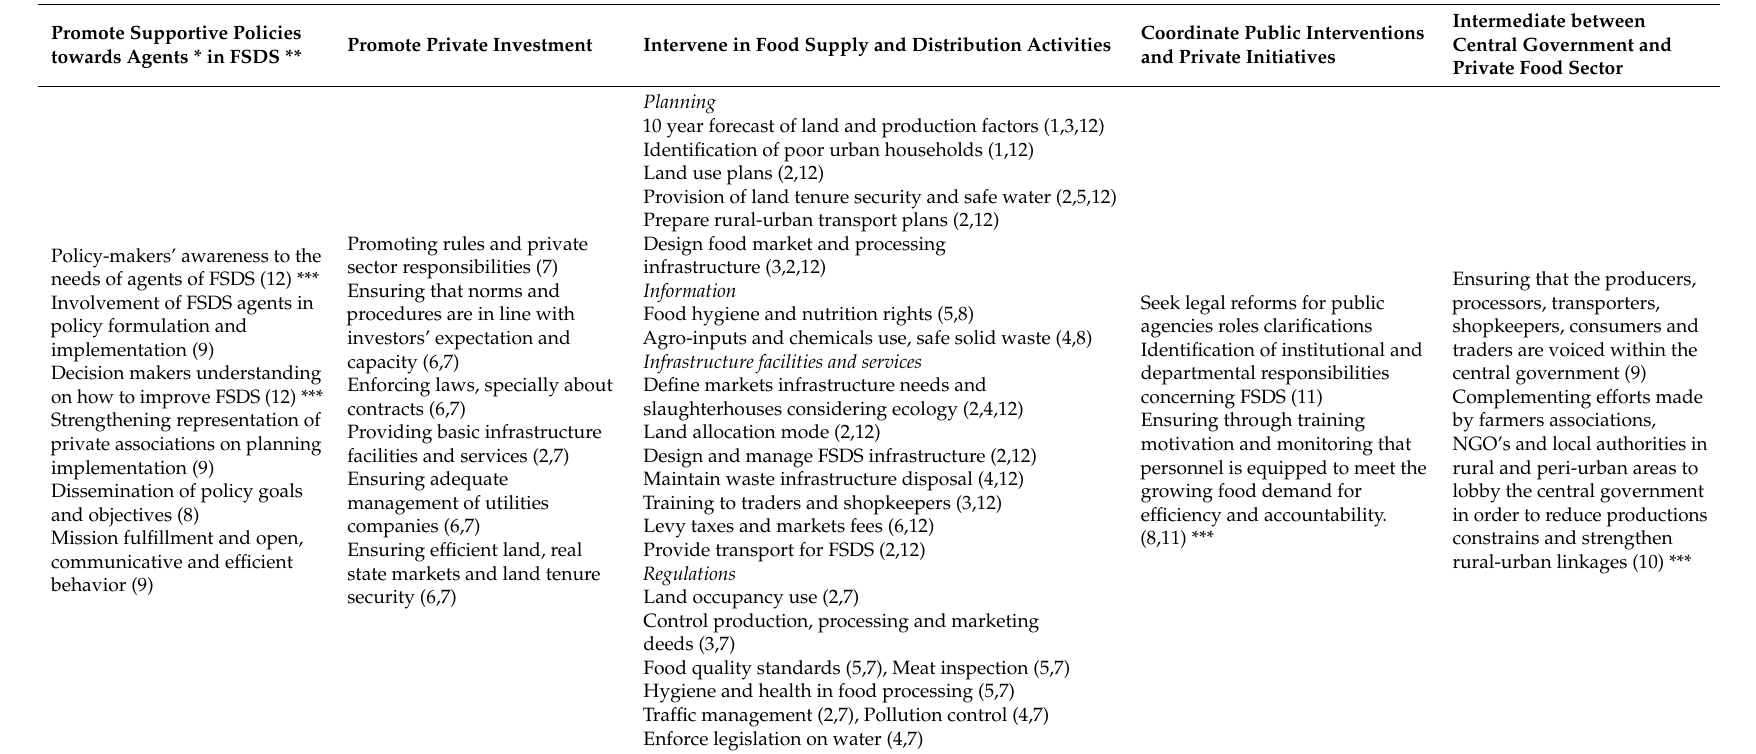
Table 1. Five main roles from municipalities to solve food insecurity of low-income urban households [23] adapted from Armendariz et al.